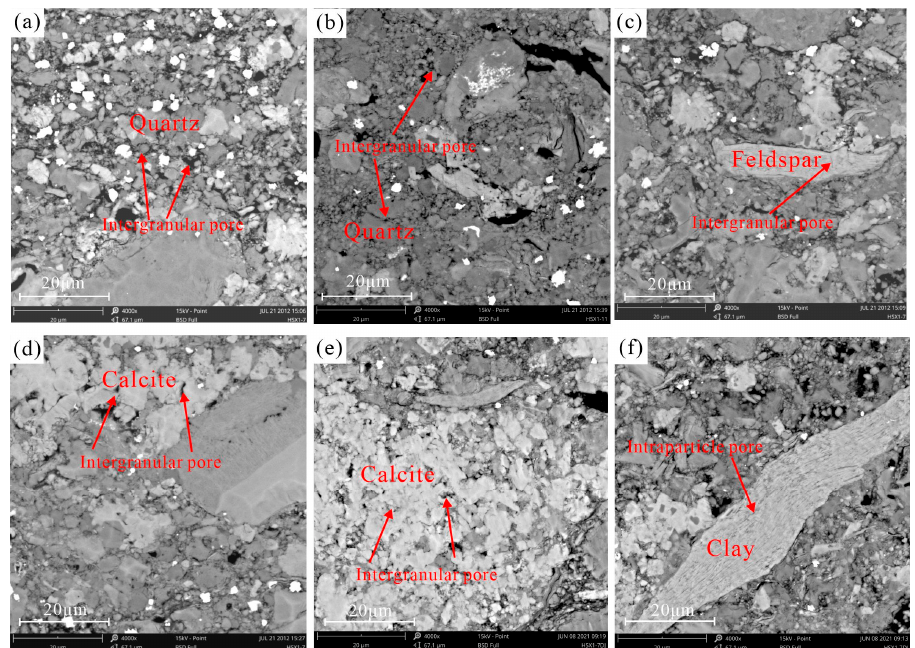
Figure 3. Types of shale reservoir space from Fengcheng Formation: ( a , b ) Interparticle pores at the edge of quartz. ( c ) Interparticle pores at the edge of feldspar. ( d , e ) The intergranular pores between calcite particles. ( f ) Intraparticle pores at the inside of clay minerals.